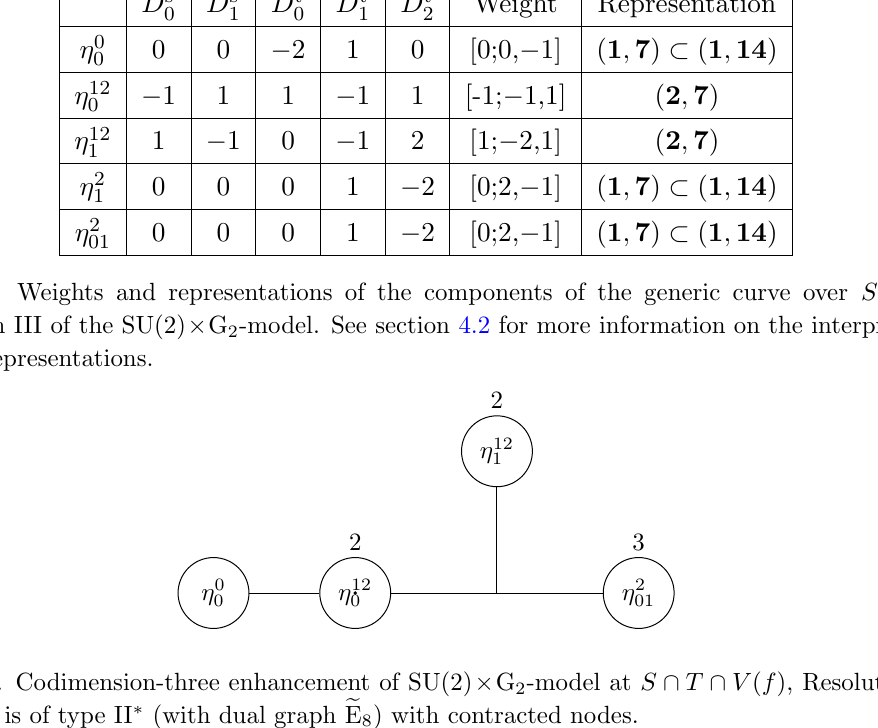
Figure 9 . Codimension-three enhancement of SU(2) (cid:2) G